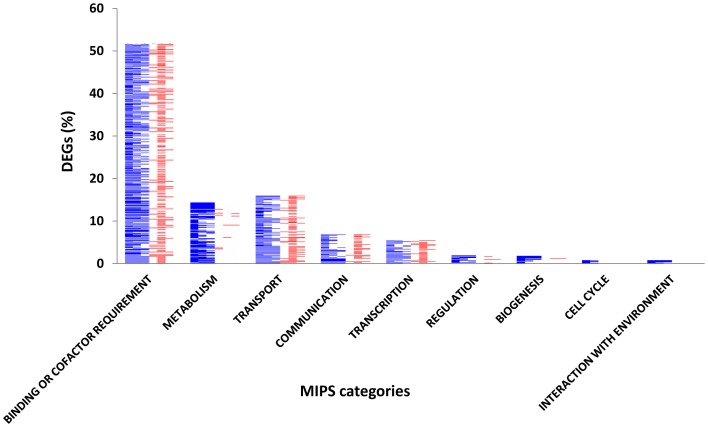
Blast2GO-annotated DEGs grouped according to the MIPS functional catalogue.The gene expression pattern across moderate stress, severe stress and recovery is shown in the form of heat maps. Blue represents the percentage of upregulated genes in HKI 1105 (tolerant genotype) while red represents downregulated genes in V 372 (susceptible genotype).